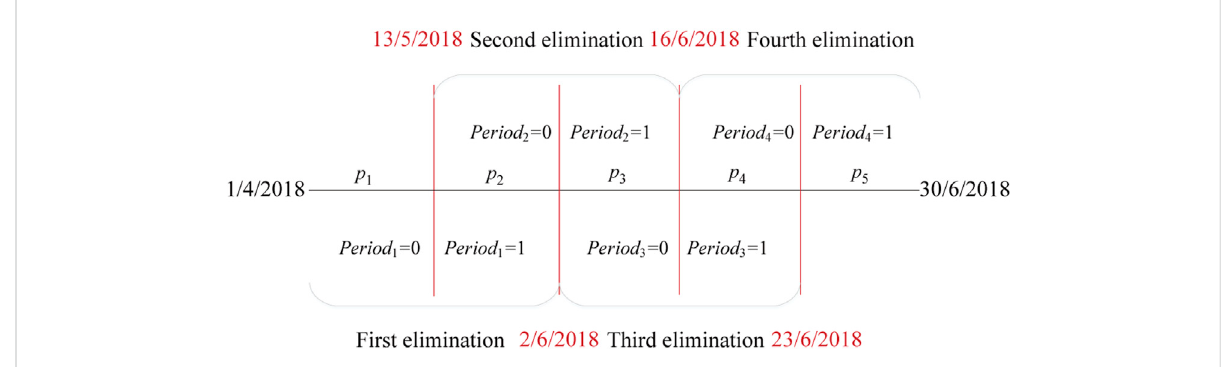
FIGURE 2 Different periods of the